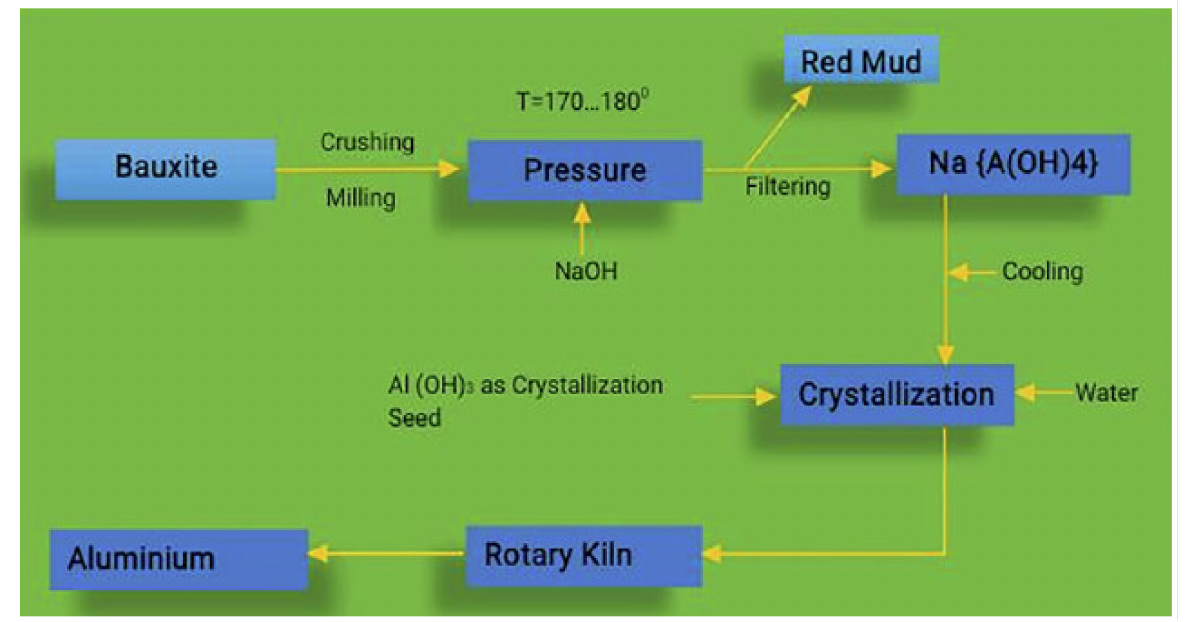
Figure 2. Manufacturing Process of RMD [35].